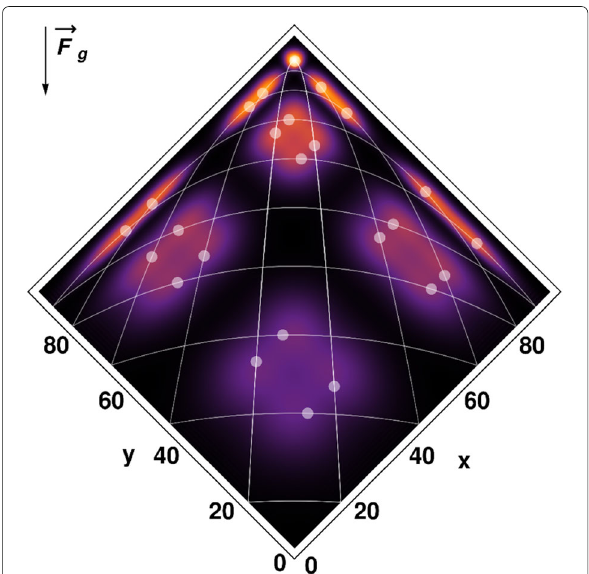
Fig. 8 Trajectories of atoms bouncing between two oscillating mirrors, located at x = 0 and y = 0, on a two-dimensional 5 × 5 time lattice. Reprinted from